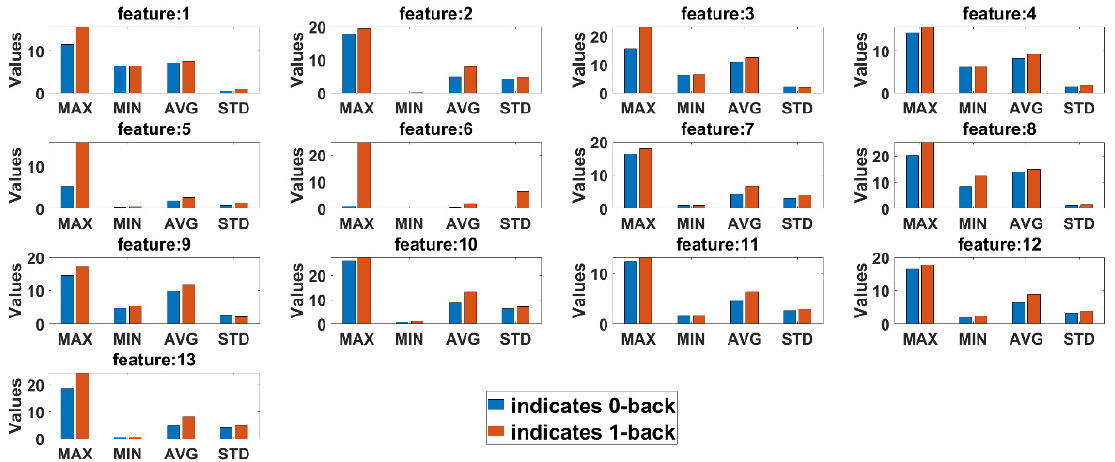
Figure 13. Summary of the statistical parameters comparing n-back task 0 and 1 considering features eyeT system.